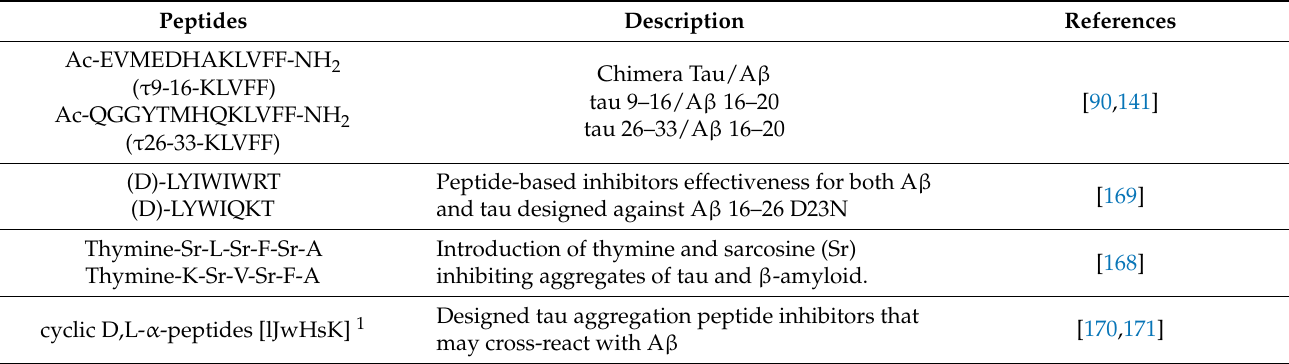
Table 1. Peptide designed for a dual property of inhibiting aggregates of tau and amyloid- β .